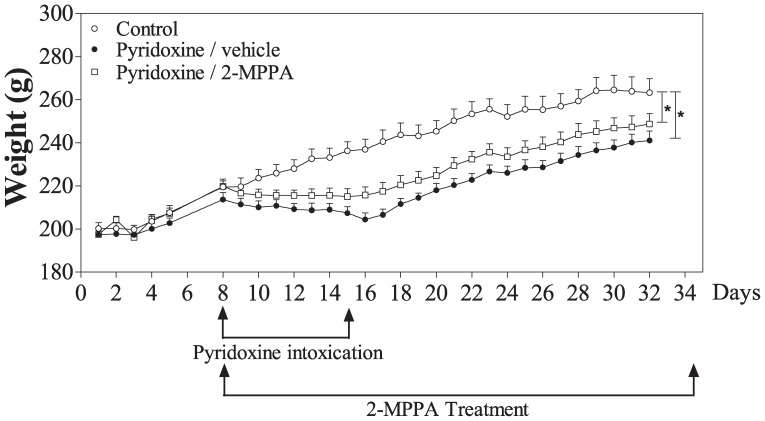
GCP II inhibition did not significantly affect weight loss induced by pyridoxine.Weights were measured every day of the study. A significant difference was observed between the controls and both the pyridoxine treated groups (p<0.05); no difference was observed between the pyridoxine/vehicle and pyridoxine/2-MPPA groups (p>0.05). N = 10/group. Data = mean ± SEM. * = p<0.05.